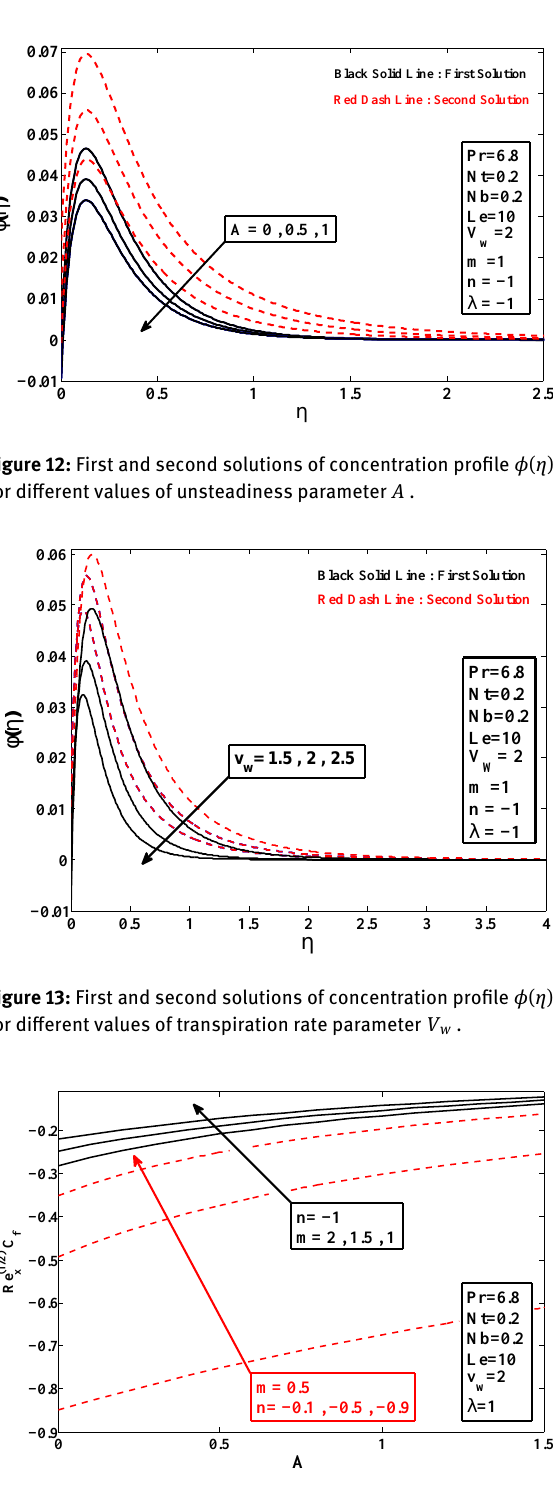
Figure 14: Effect of first-order slip parameter m and second-order slip parameter n on skin friction Re 1/2 x C f